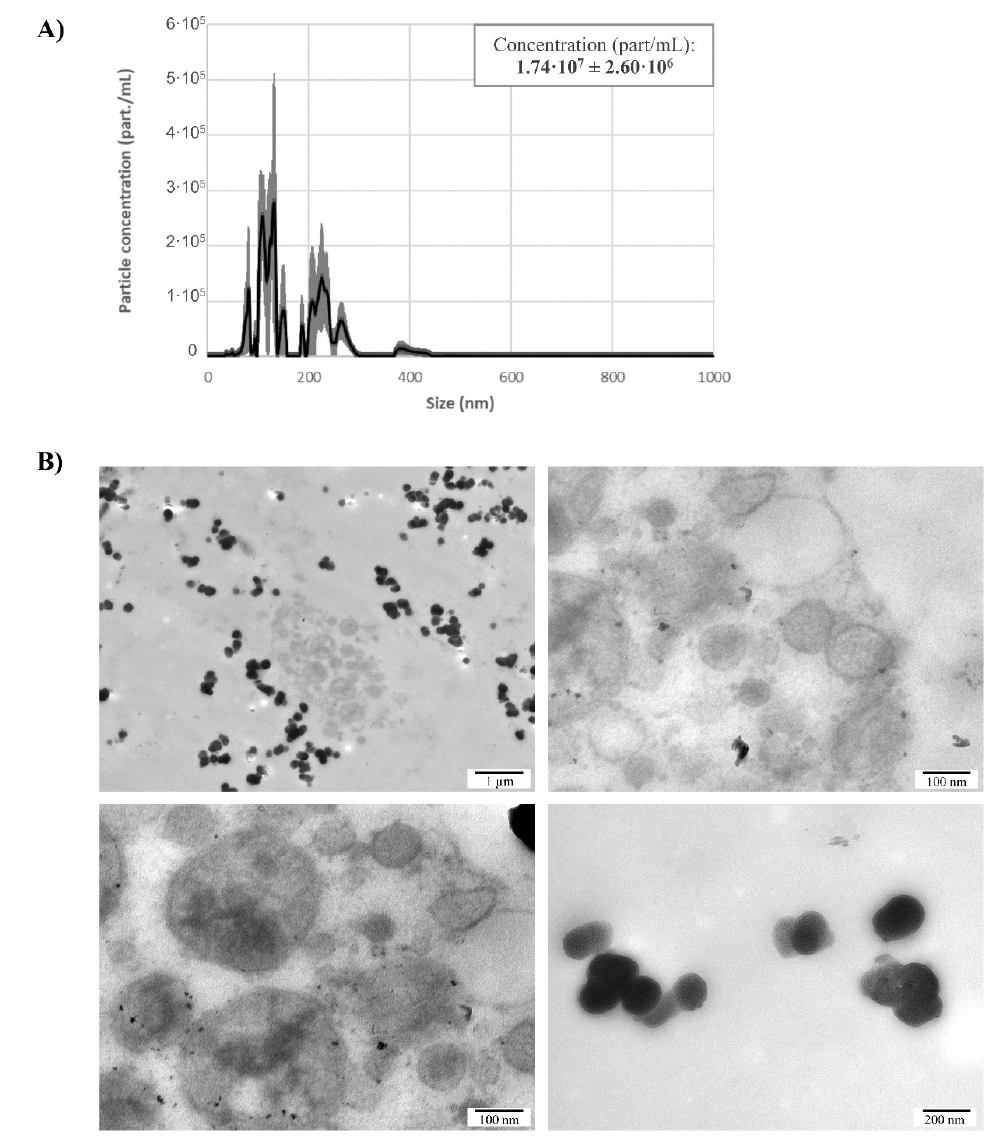
Figure 2. Isolation of naEVs from E4.5 blastocyst spent media. ( A ) Size distribution and quantification using nanoparticle tracking analysis of naEVs isolated from spent blastocyst media. Net particle concentration was calculated after subtracting particles found in the same volume of blank media. Values represent the mean of three independent experiments ±SEM. ( B ) Different images showing morphological characterization of naEVs in spent culture media by TEM. Particles of different aspects, electron densities and sizes ranging from 20–500 nm were observed.